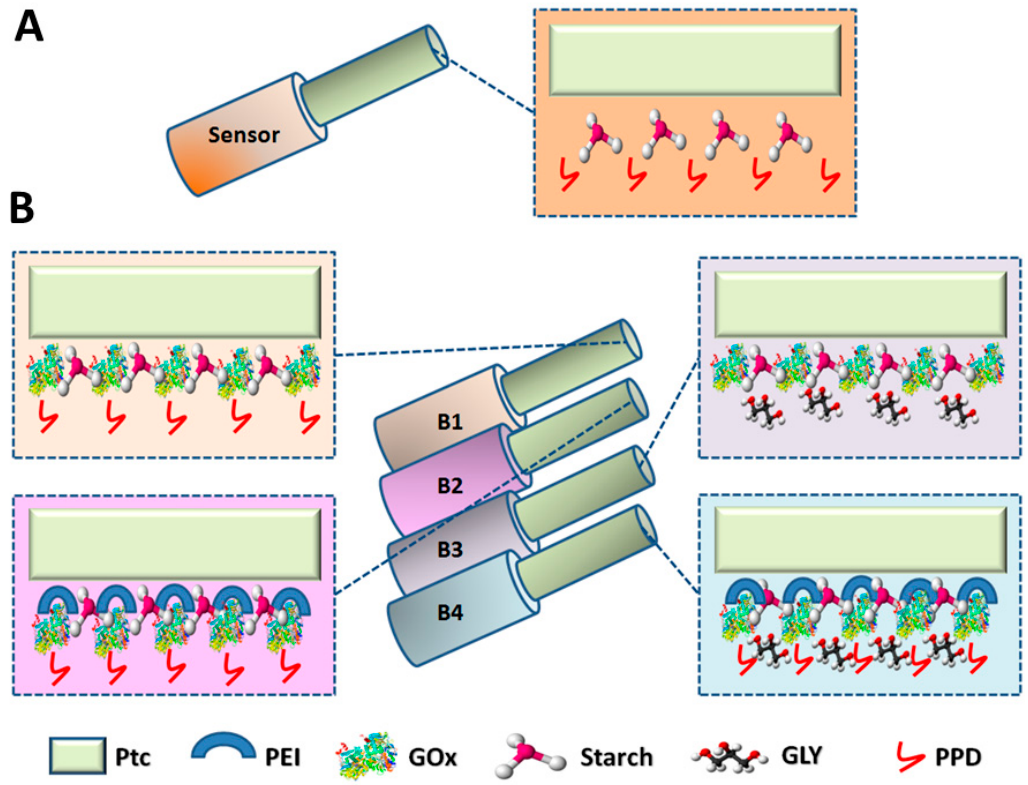
Figure 1. Schematic representation of sensors (Panel A ) and the main designs of starch-based biosensors (Panel B ) (n = 4) analyzed in this study. B1: Pt c / [GEL(5%) + GOx] 5 / PPD; B2: Pt c / [GEL(5%) hydrogel biosensors (Panel B ) (n = 4) analyzed in this study. B1: Pt c /[GEL(5%) + GOx] 5 /PPD; B2: + PEI(1%) + Gox] / PPD; B3: Ptc / [GEL(5%) + GLY(1%) + Gox] / PPD; B4: Pt / [GEL(5%) + PEI(1%) c 5 5 Pt c /[GEL(5%) + PEI(1%) + Gox] 5 /PPD; B3: Ptc/[GEL(5%) + GLY(1%) + Gox] 5 /PPD; B4: Pt c /[GEL(5%) + PEI(1%) + GLY(1%) + Gox] 5 /PPD. Ptc: Pt cylinder 1 mm long, 125 μ m diameter; GEL: starch-based